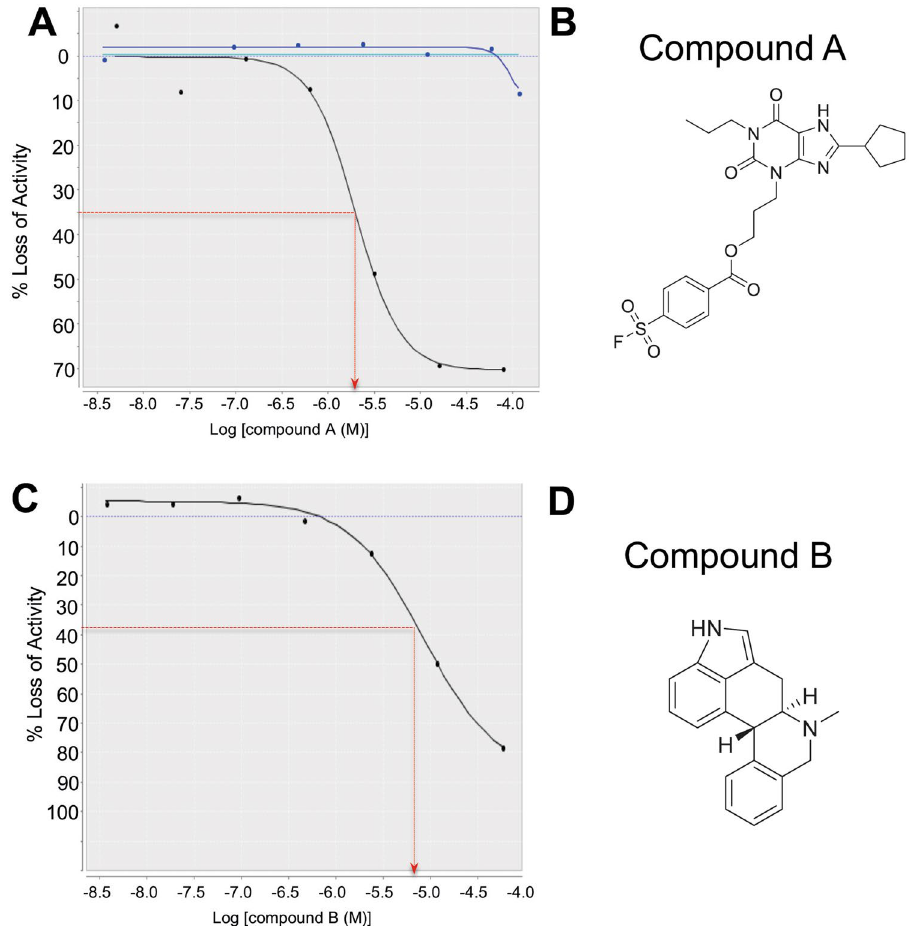
Figure 3. RAS hit compounds from Abd screen AlphaScreen. The Sigma-Aldrich LOPAC 1280 of 1280 bioactive compounds collection and Tocris 1280 compounds library were screened using the AlphaScreen assay. Two compounds were selected for study using dose–response inhibition of the interaction between HRAS G12V - GTPγS and iDAb RASdm. Panel ( A ) shows dose response of the hit compound A (FSCPX, shown in Panel ( B )). The blue line represents data when a non-relevant compound (a non-binder of either HRAS or antibody) is added in the assay, showing there is no interference in the AlphaAssay. Panel ( C ) shows the dose response of compound B (CY 208–243, panel D). Panel ( B ) is the chemical structure of compound A (8-Cyclopentyl- 3-(3-((4-(fluorosulfonyl)benzoyl)oxy)propyl)-1-propylxanthine) and panel ( D ) is the chemical structure of compound B (indolophenanthridine or 4,6,6a,7,8,12b-hexahydro-7-methylindolo(4,3-ab)-phenanthridine). The graphs show the percentage inhibition of signal from interaction of the scFv RASdm and HRAS G12V -GTPγS (black lines) with increasing concentrations of compounds (compared to the activity without compounds). Compound A shows 2 µM IC 50 and compound B shows 6 µM IC 50 for the of binding of the dematured antibody with RAS